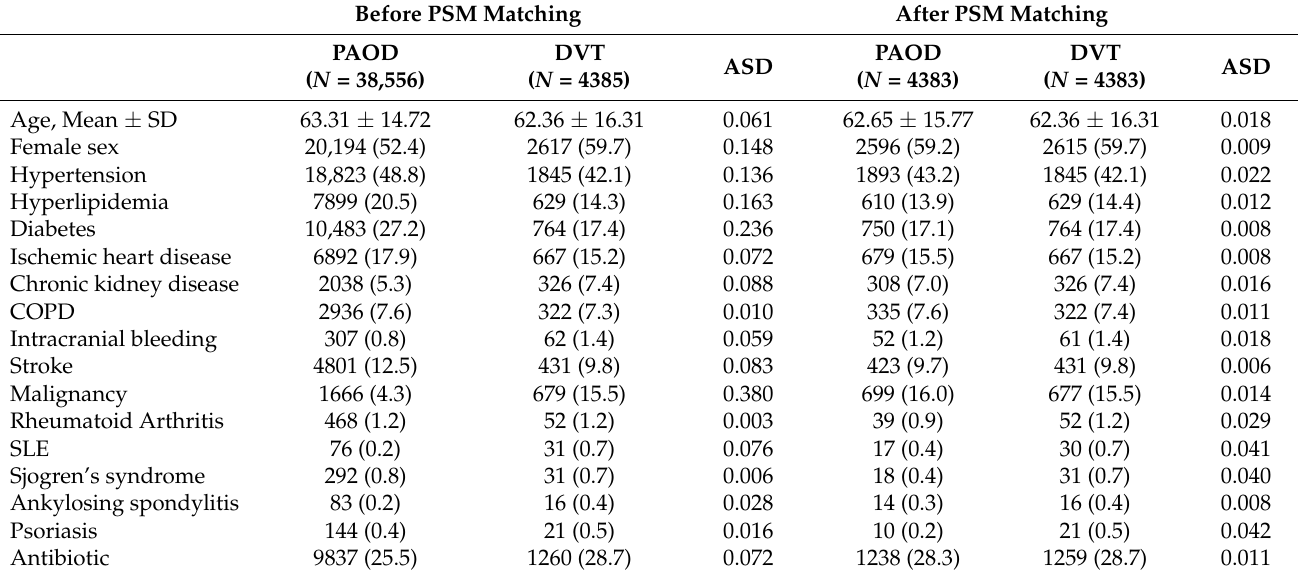
Figure 1. Flowchart of patient selection. Table 1. Demographic characteristics of PAOD and DVT.